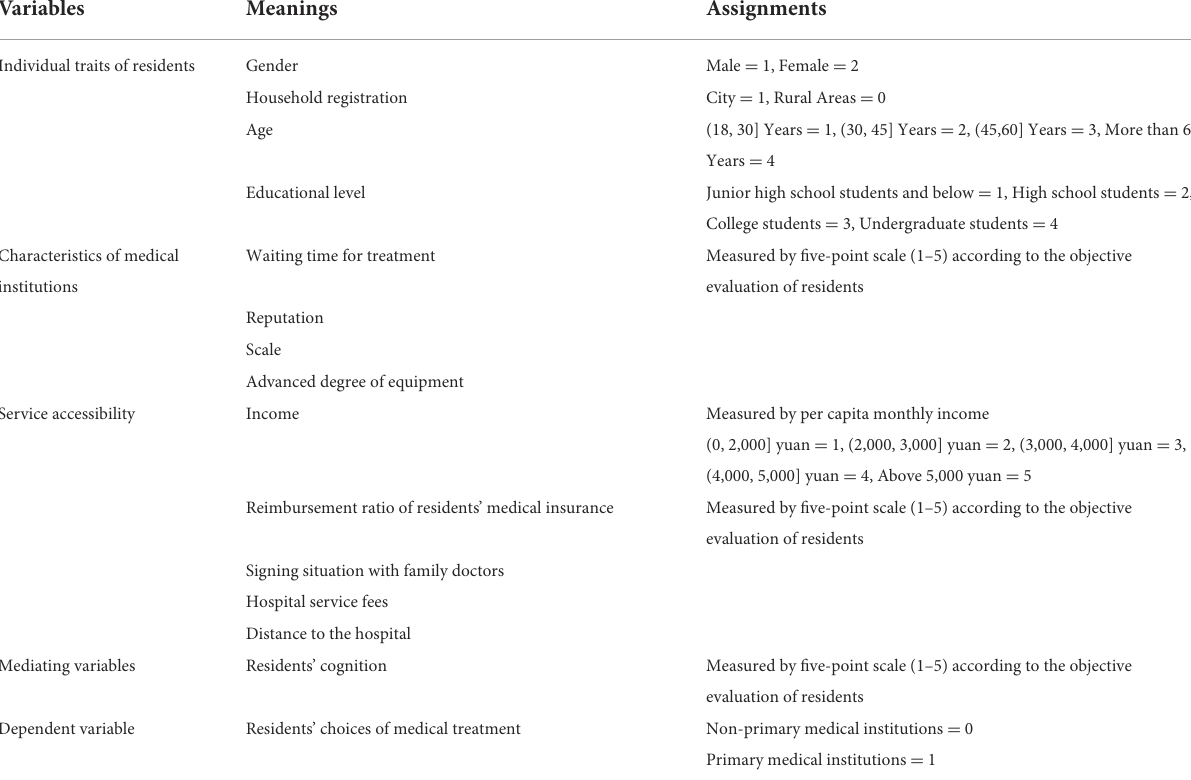
TABLE 1 Explanatory variables and